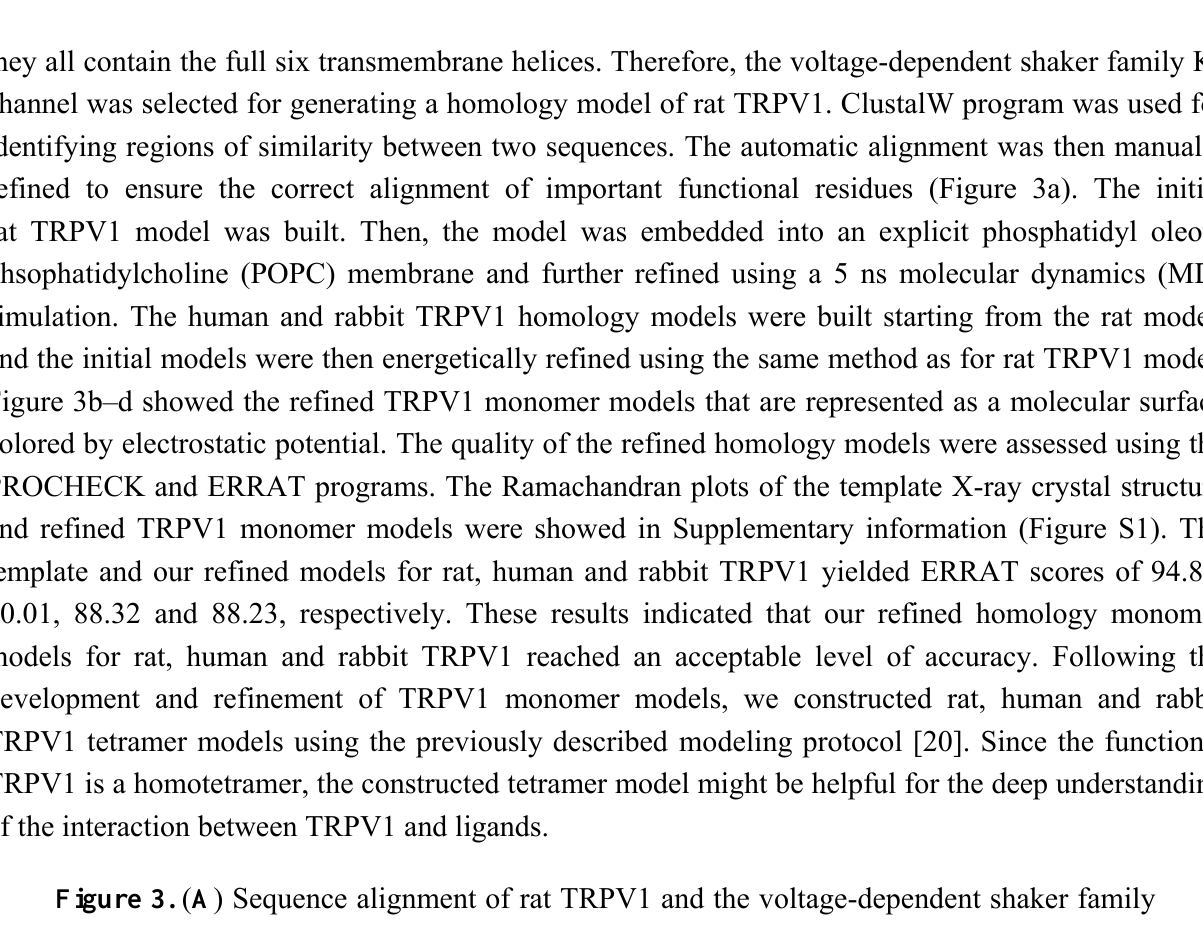
Figure 3. ( A ) Sequence alignment of rat TRPV1 and the voltage-dependent shaker family K + channel (PDB code: 2R9R). The identical, strongly conserved, and weakly conserved residues are denoted, respectively, with red, orange, and yellow boxes. ( B – D ) Homology models for rat TRPV1 ( B ), human TRPV1 ( C ) and rabbit TRPV1 ( D ). Models are represented as a molecular surface colored by electrostatic potential. The color ramp for electrostatic potential ranges from red (most negative) to blue (most